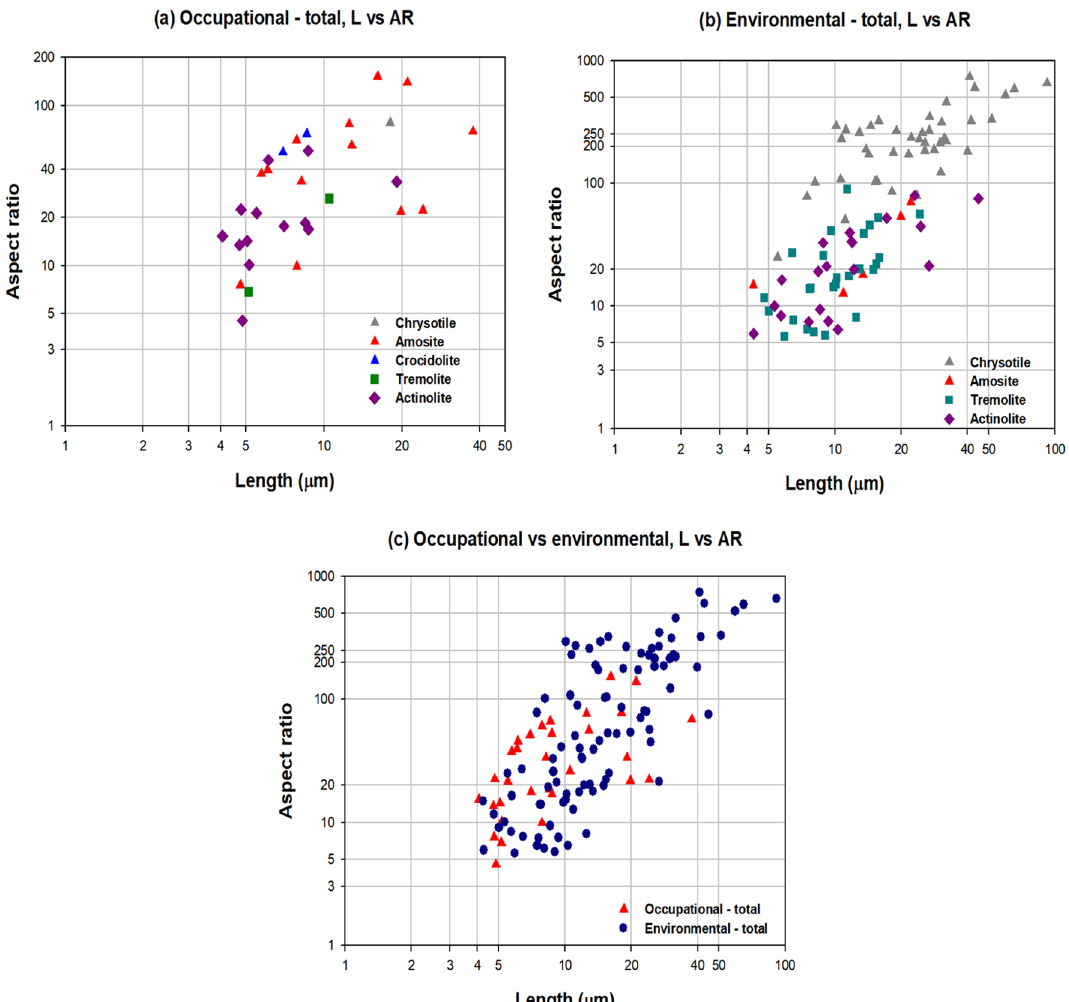
Figure 1. Distribution of asbestos fiber length and aspect ratio according to type of asbestos exposure. ( a ) Occupational—total, L vs. AR. ( b ) Environmental—total, L vs. AR. ( c ) Occupational vs. environmental, L vs.